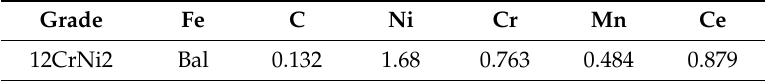
Table 2. Chemical composition of the 12CrNi2 materials (quality components, %).